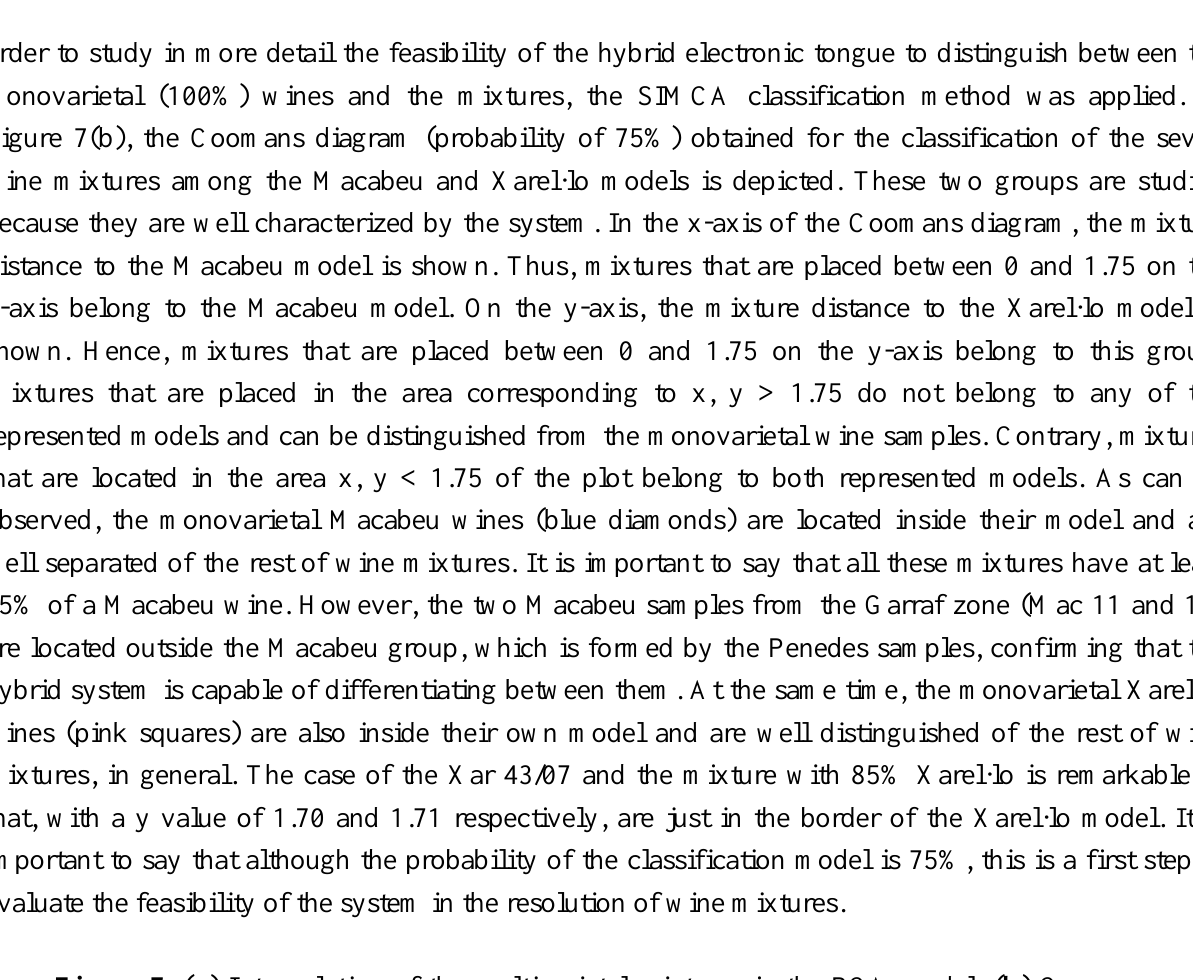
Figure 7. ( a ) Interpolation of the multivarietal mixtures in the PCA model; ( b ) Coomans diagram for the Macabeu and Xarel·lo models with a probability of